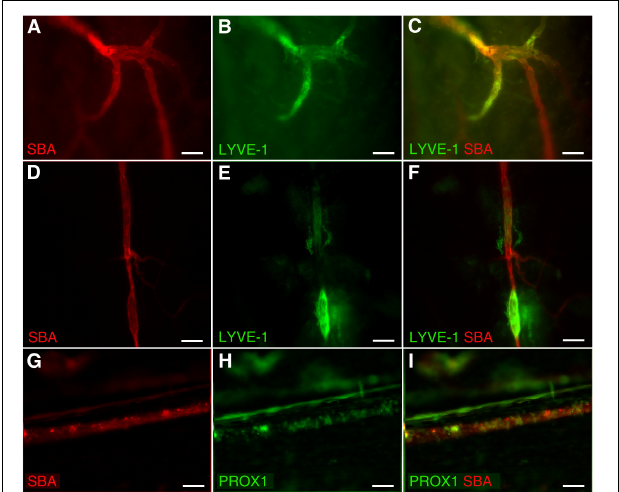
FIGURE 3 | Dual vessel specification within the same vascular network or a single vessel. Blood and lymphatic structures were visualized by spinning disk confocal microscopy in wild type C57BL/6J mice by transcardial perfusion with Kreb’s/albumin solution containing AlexaFluor 594-conjugated SBA lectin and AlexaFluor 488-conjugated anti-mouse Lyve-1 antibody, respectively. (A–C) Significant parts of the microvascular network exhibit both blood (SBA lectin, red) and lymphatic (LYVE-1, green) identity. (D–F) A single blood (SBA lectin, red) microvessel with the segments exhibiting lymphatic (LYVE-1, green) identity as well. (G–I) Mosaic SBA lectin (red)/Prox1 (green) positivity pattern within a single vessel in Prox1 eGFP mice. To visualize the blood vasculature, Prox1eGFP mice, in which lymphatic vessels exhibit bright green fluorescence, the hearts were perfused with Kreb’s/albumin solution containing AlexaFluor 594-conjugated SBA lectin. In (A,D,G) SBA lectin staining (red). In (B,E) anti-LYVE-1 staining (green). In (H) Prox1 signal (green). In (C,F,I) superimposed images. Scale bars 50 µ